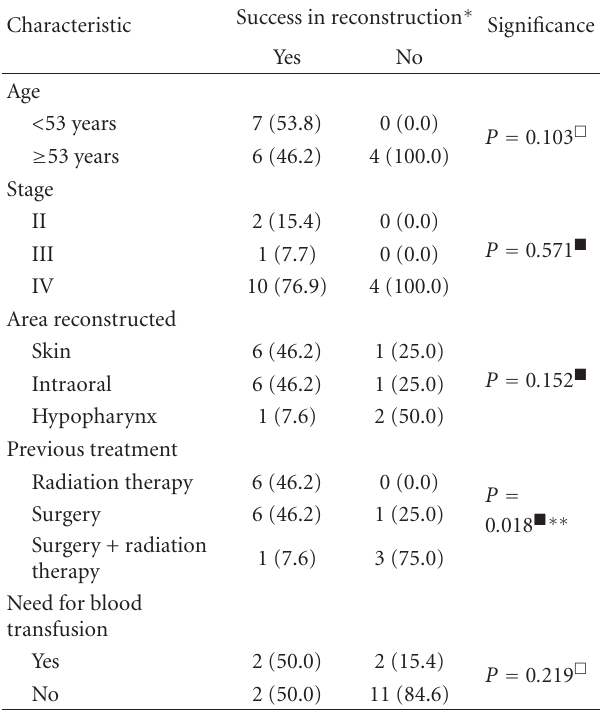
Table 4: Analysis of the variables determining failure in reconstruc-